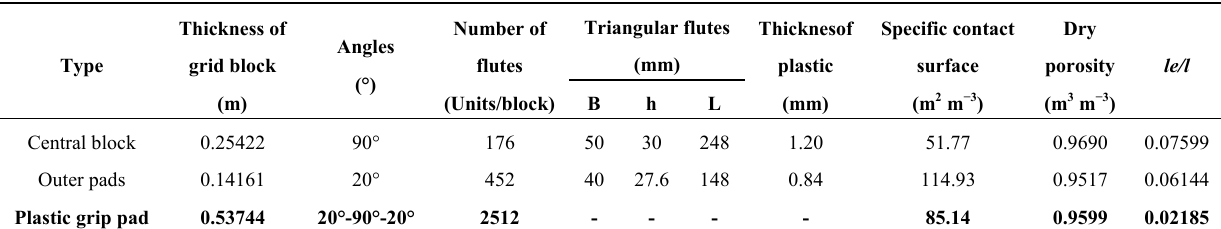
Table 1. Summary of the geometric parameters of the plastic